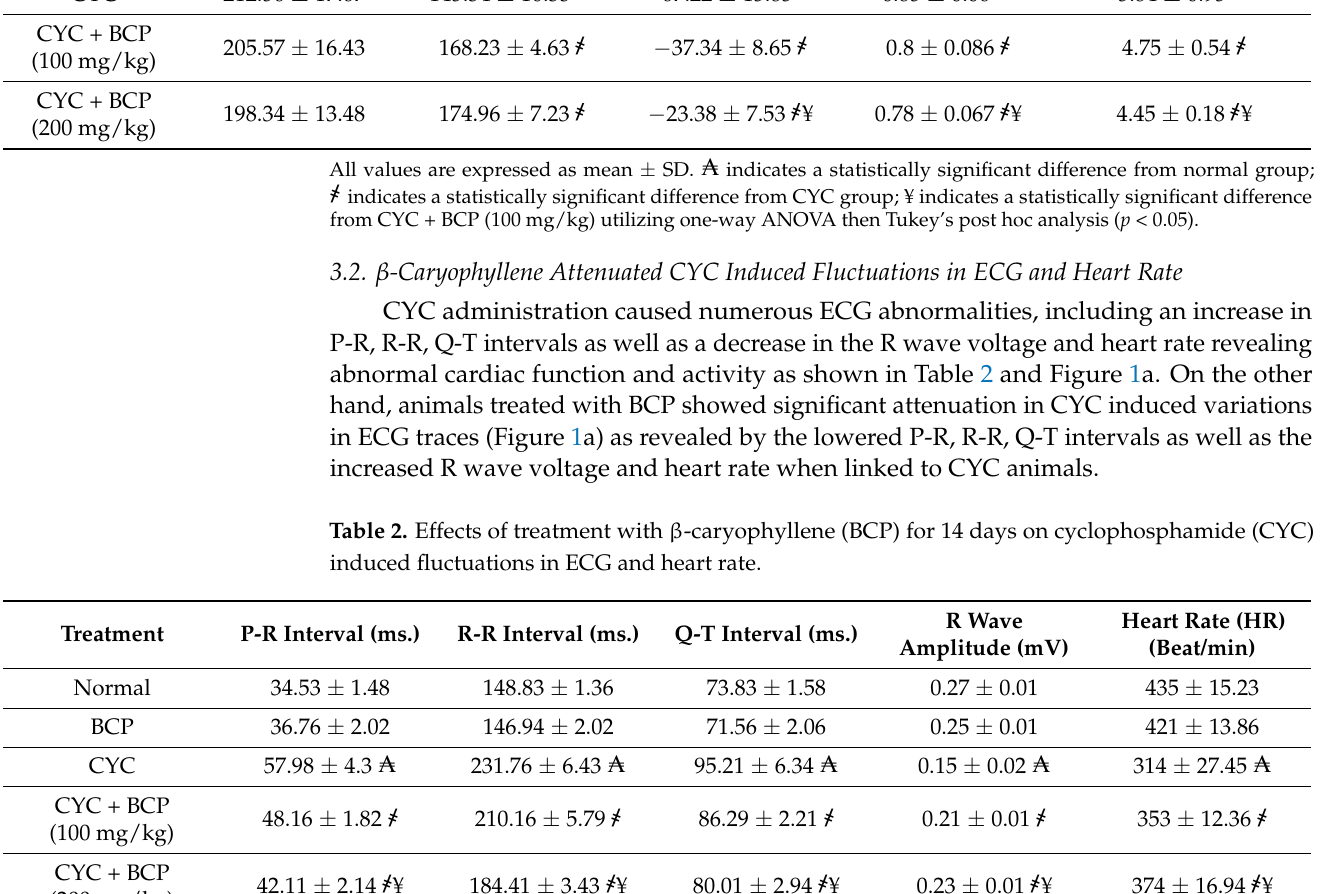
Table 1. Effects of treatment with β -caryophyllene (BCP) for 14 days on cyclophosphamide (CYC) induced fluctuations in body and heart weights and heart to body weights ratio in rat.